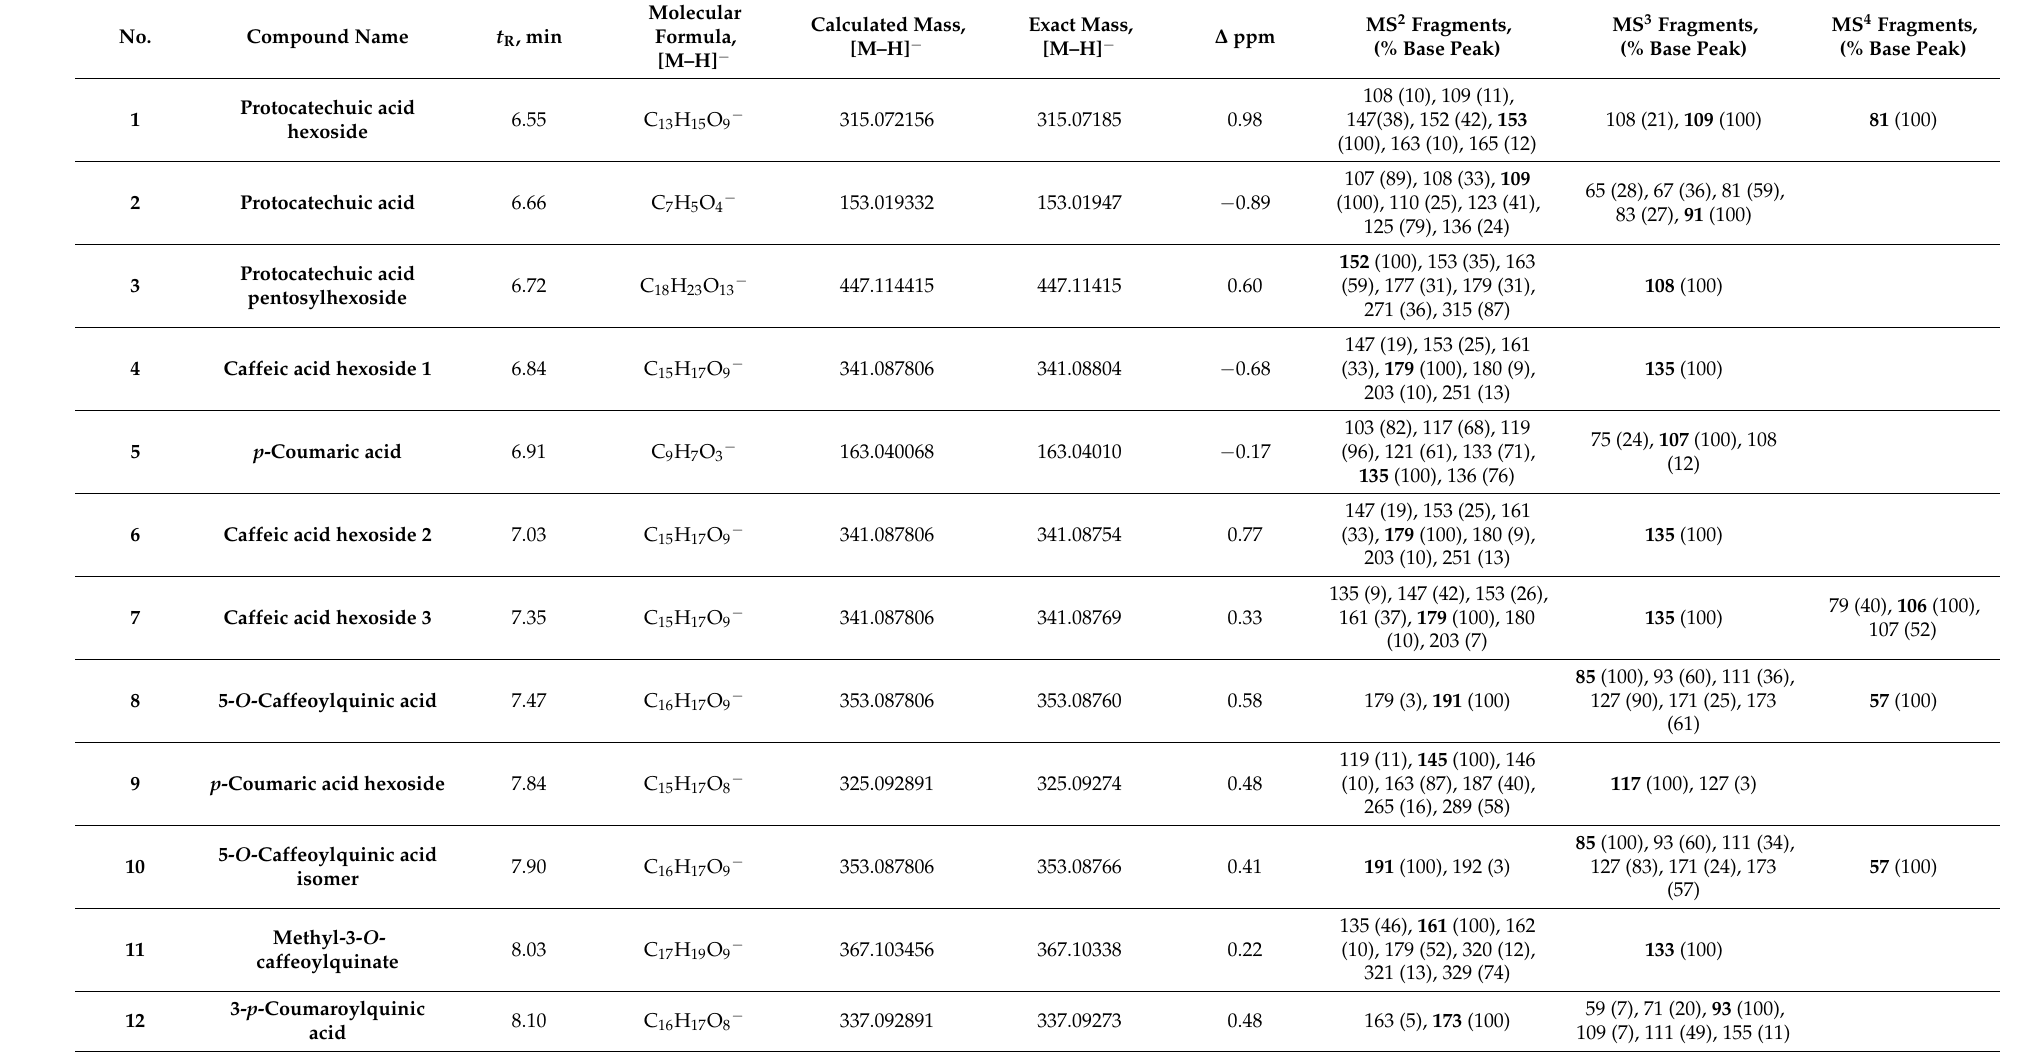
Table 3. Ultra-high performance liquid chromatography-MS 4 (UHPLC-MS 4 ) data about the identification of the main compounds in the